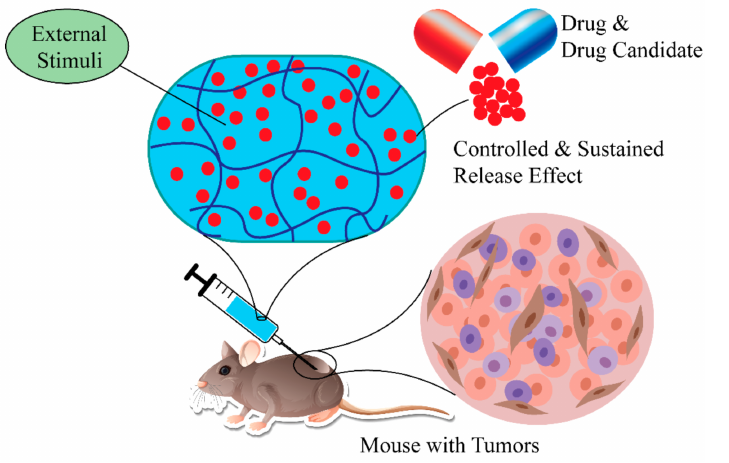
Figure 8. Using SHH in delivery of therapeutic agents. SHH effectively delivery therapeutic agents to the target tissue. Furthermore, drug release kinetics can be controlled by external stimuli (temperature, pressure, magnetic field). SHH: Self-healing